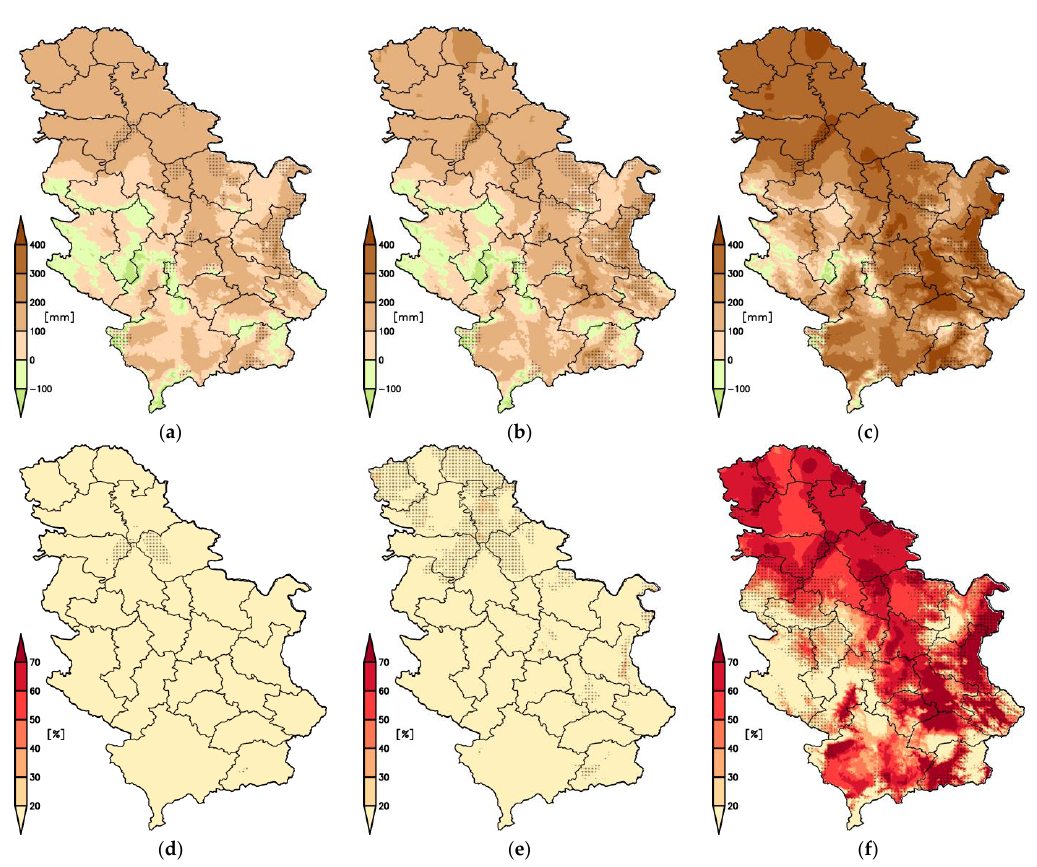
Figure 9. Upper row: average water deficit (mm) for different fruits in 1998 – 2017. Black dots mark areas where the change between the periods 1998 – 2017 and 1961 – 1990 was statistically significant. Lower row: frequency of years in which observed water deficit was larger than 300 mm in the period 1998 – 2017. Black dots mark areas where the frequency has increased more than 10% between the periods 1998 – 2017 and 1961 – 1990. Results for cherries ( a ) and ( d ), apricots and peaches ( b ) and ( e ), apples, pears, and plums ( c ) and ( f ).